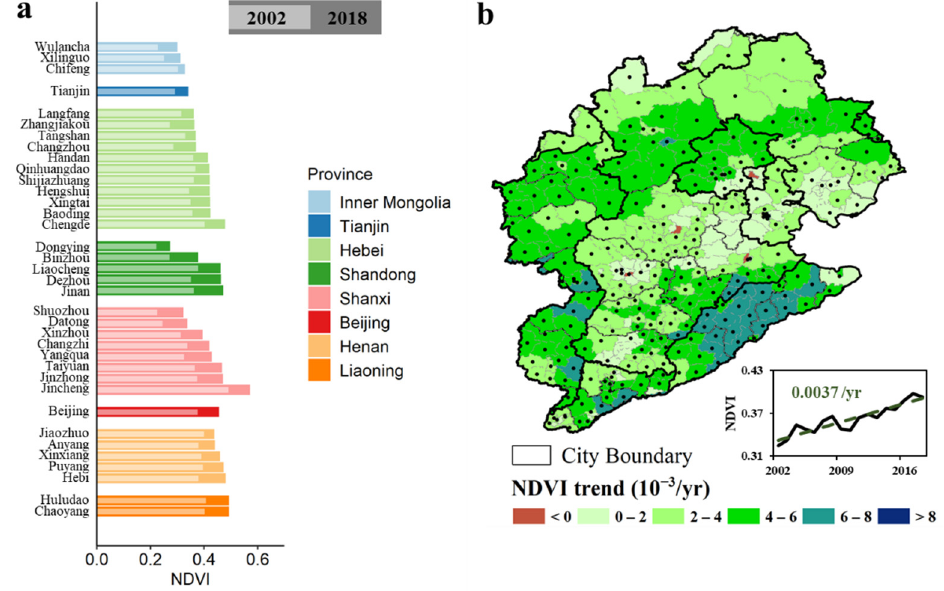
Figure 2. ( a ) Increased normalized difference vegetation index (NDVI) in each county and ( b ) annual NDVI trends in each county, from 2002 to 2018. The black dots in ( b ) imply that the trends are statistically significant ( p -value < 0.05).